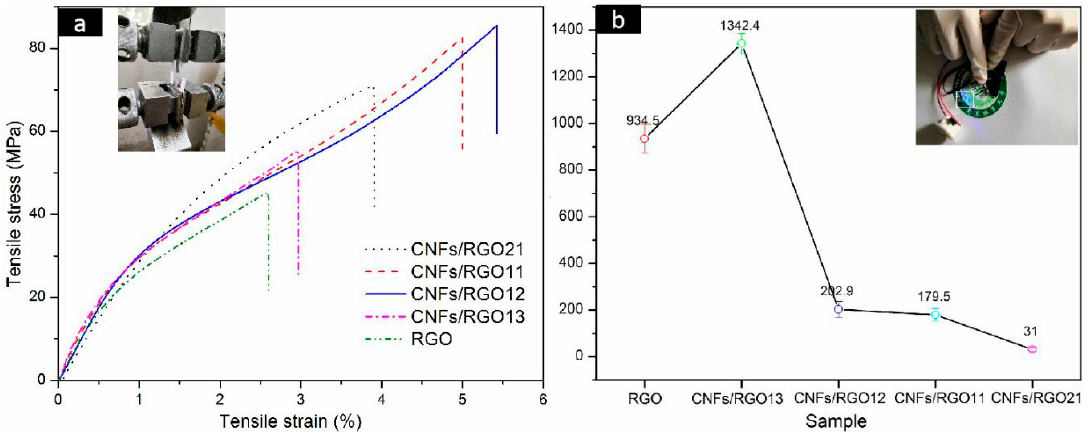
Figure 6. ( a ) Tensile stress − strain curves of the RGO and CNF/RGO films. ( b ) Conductivity of the RGO and CNF/RGO films.